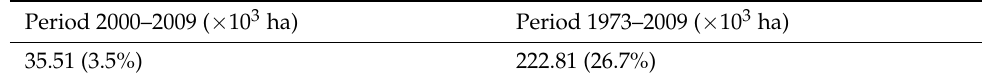
Table 2. Increase in soil salinity salt-affected area from 1973 to 2009